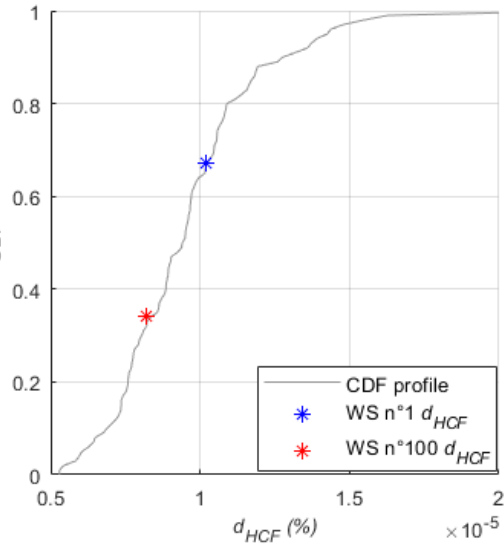
Figure 8. Estimated damage CDF for a WS series with the following parameters: V = 11 m · s − 1 and TI = 10% over a period of 10 min.